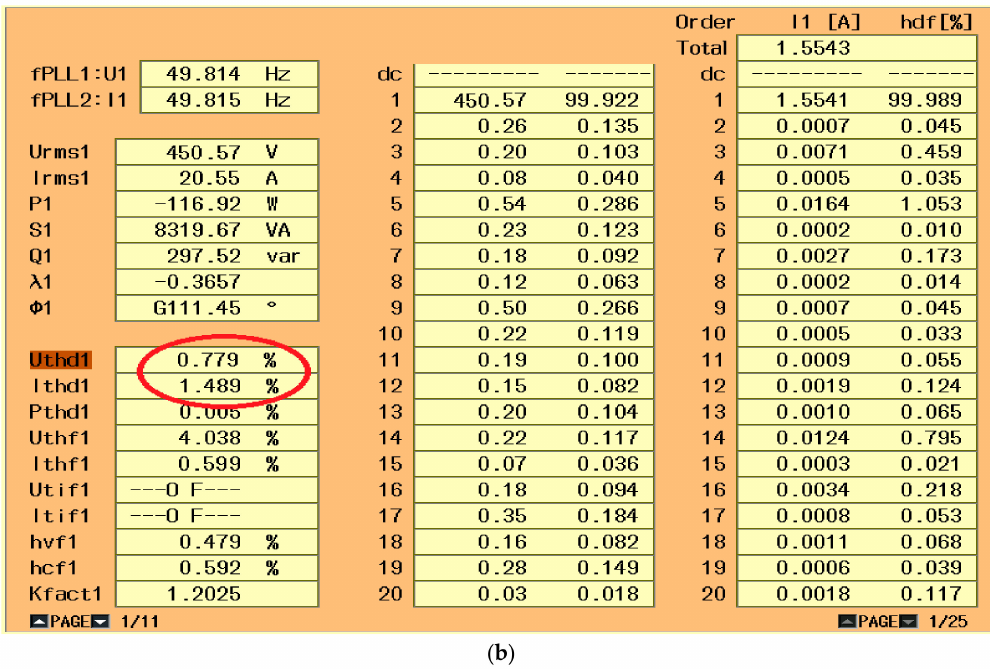
Figure 20. ( a ) Comparison of output voltage and current in phase-A; and ( b ) THD analysis of stepped output